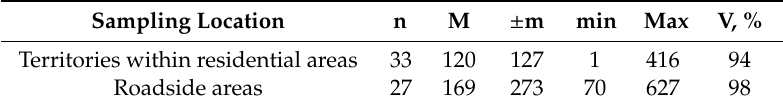
Table 6. Statistical parameters of the magnetic susceptibility of the upper soil horizons (0–10 cm) of the residential zone of Gubakha, × 10 − 5 SI ( p = 0.05).